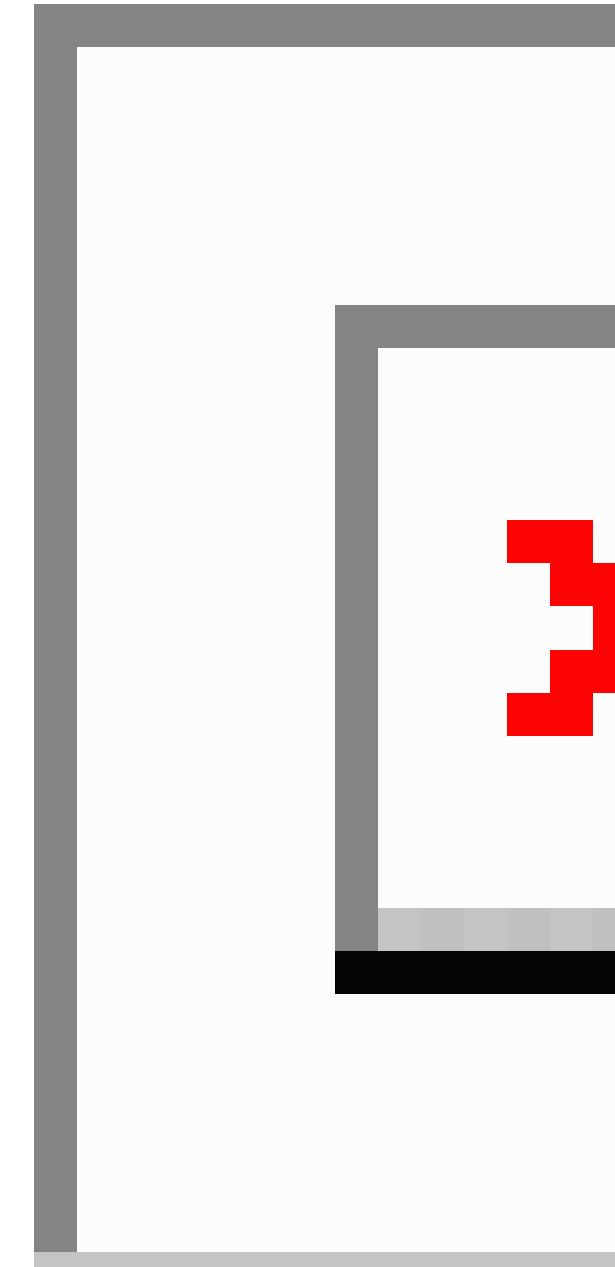
Figure 1. Flow of participants through the